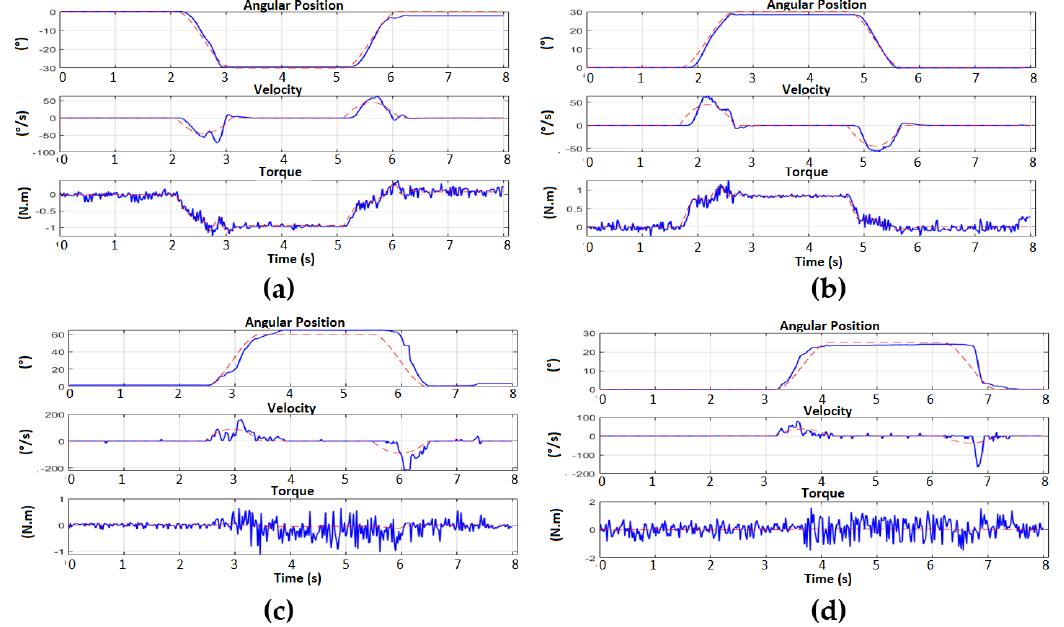
Figure 26. Right arm movements by generating polynomial trajectories. ( a ) Motor 1 from 0 ◦ to − 30 ◦ ; ( b ) Motor 2 from 0 ◦ to 30 ◦ ; ( c ) Motor 3 from 0 ◦ to 60 ◦ ; ( d ) Motor 4 from 0 ◦ to 25 ◦